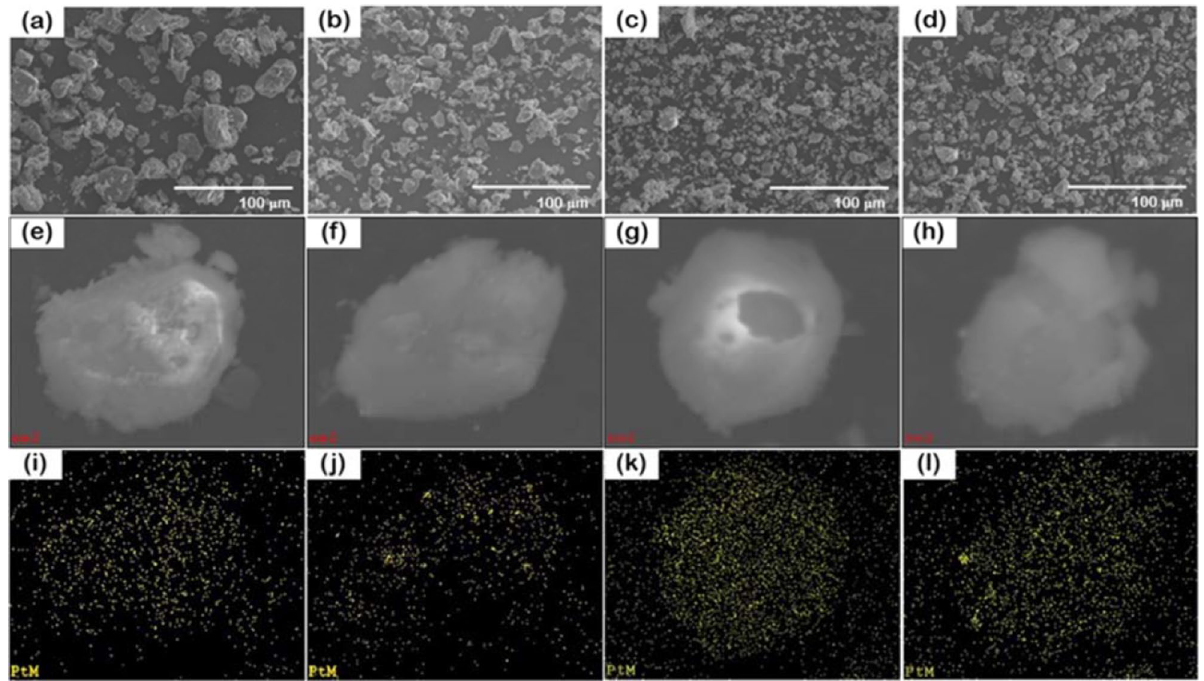
Figure 1. SEM images of ( a , e ) fresh Pt/γ-Al 2 O 3 , ( b , f ) reused Pt/γ-Al 2 O 3 , ( c , g ) fresh Pt/WO x /γ-Al 2 O 3 , ( d , h ) reused Pt/WO x /γ-Al 2 O 3 , the elemental distribution via SEM–EDX of ( i ) fresh Pt/γ-Al 2 O 3 , ( j ) reused Pt/γ-Al 2 O 3 , ( k ) fresh